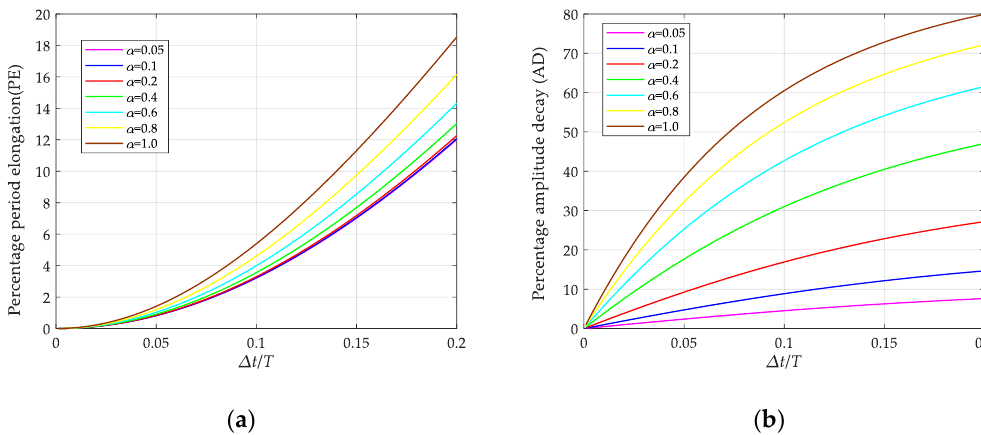
Figure 4. Percentage of period elongation and amplitude decay of the proposed scheme with numerical damping: ( a ) Percentage of period elongation. ( b ) Percentage of amplitude decay.